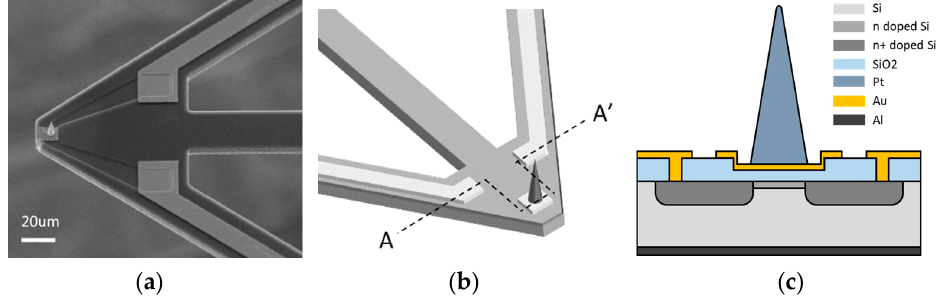
Figure 2. The ToGoFET probe: ( a ) An electron micrograph; ( b ) schematics of the cantilever and built-in MOSFET; ( c ) cross-section of the MOSFET.